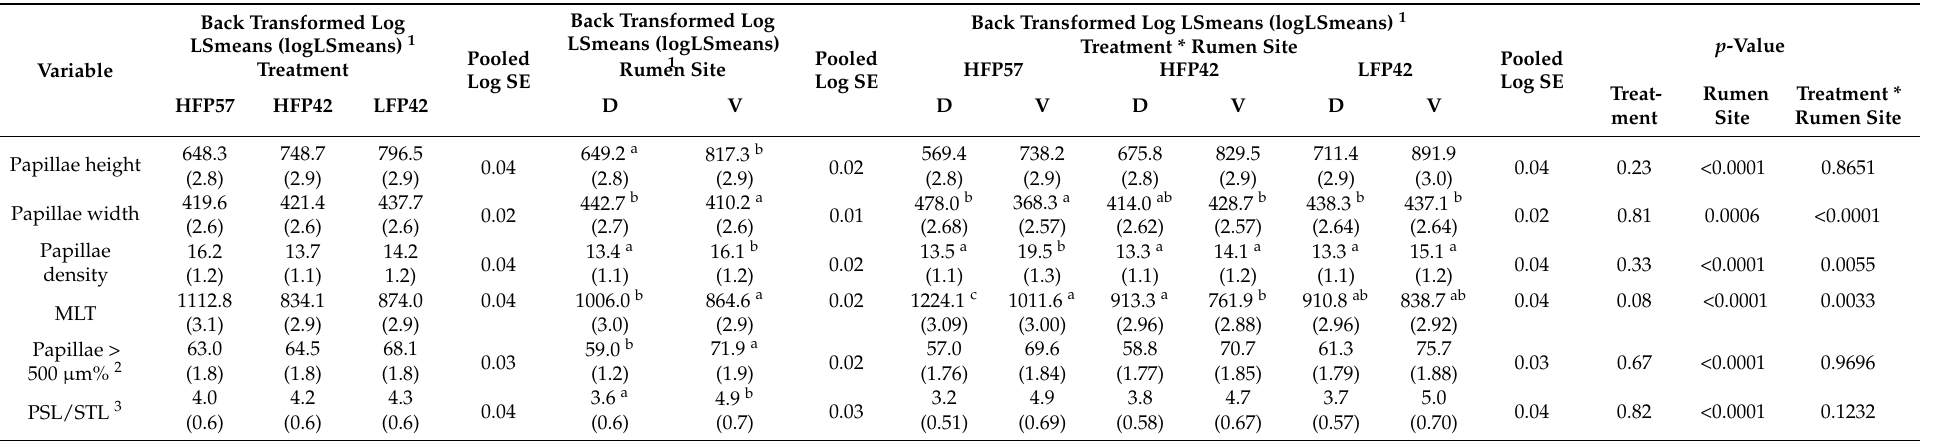
Table 4. Effect of three lamb-rearing treatments (HFP57, high fibre concentrate pellets and milk feeding to 57 d of age; HFP42, high fibre concentrate pellets and early weaning; LFP42, low fibre concentrate pellets and early weaning) on papillae height ( µ m), width ( µ m), density (papillae number/cm), muscle layer thickness ( µ m, MLT), longer (>500 µ m) papillae percentage and papillae surface length to straight tissue length (PSL/STL) ratio at the rumen dorsal and ventral sites (D, dorsal rumen site; V, ventral rumen site; SE, standard error).